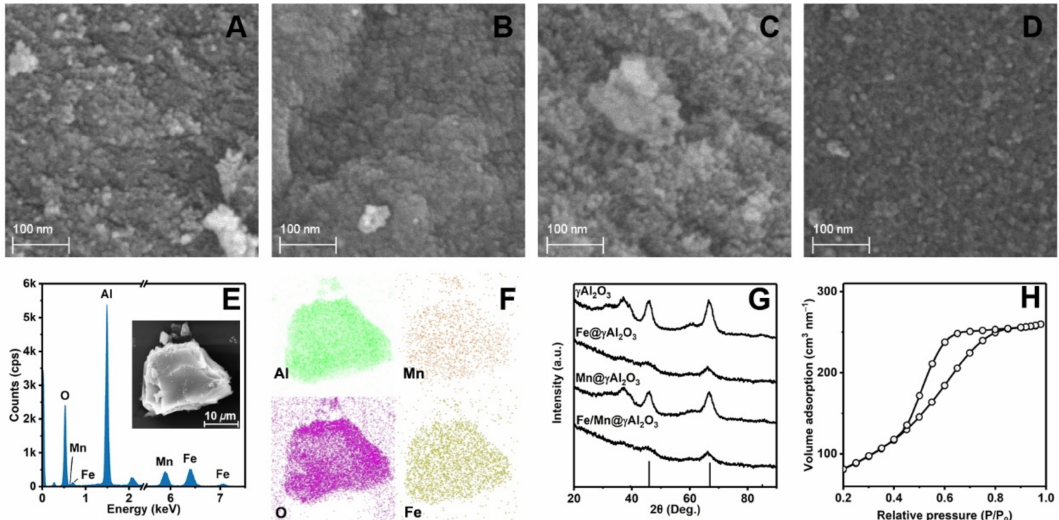
Figure 1. The SEM of γ − Al 2 O 3 ( A ), Fe@ γ − Al 2 O 3 ( B ), Mn@ γ − Al 2 O 3 ( C ), Fe/Mn@ γ − Al 2 O 3 ( D ); the EDS spectra of the synthesized catalysts ( E ); the elemental mapping of the Fe/Mn@ γ − Al 2 O 3 ( F ); the powder XRD patterns ( G ); the N 2 adsorption − desorption isotherms ( H